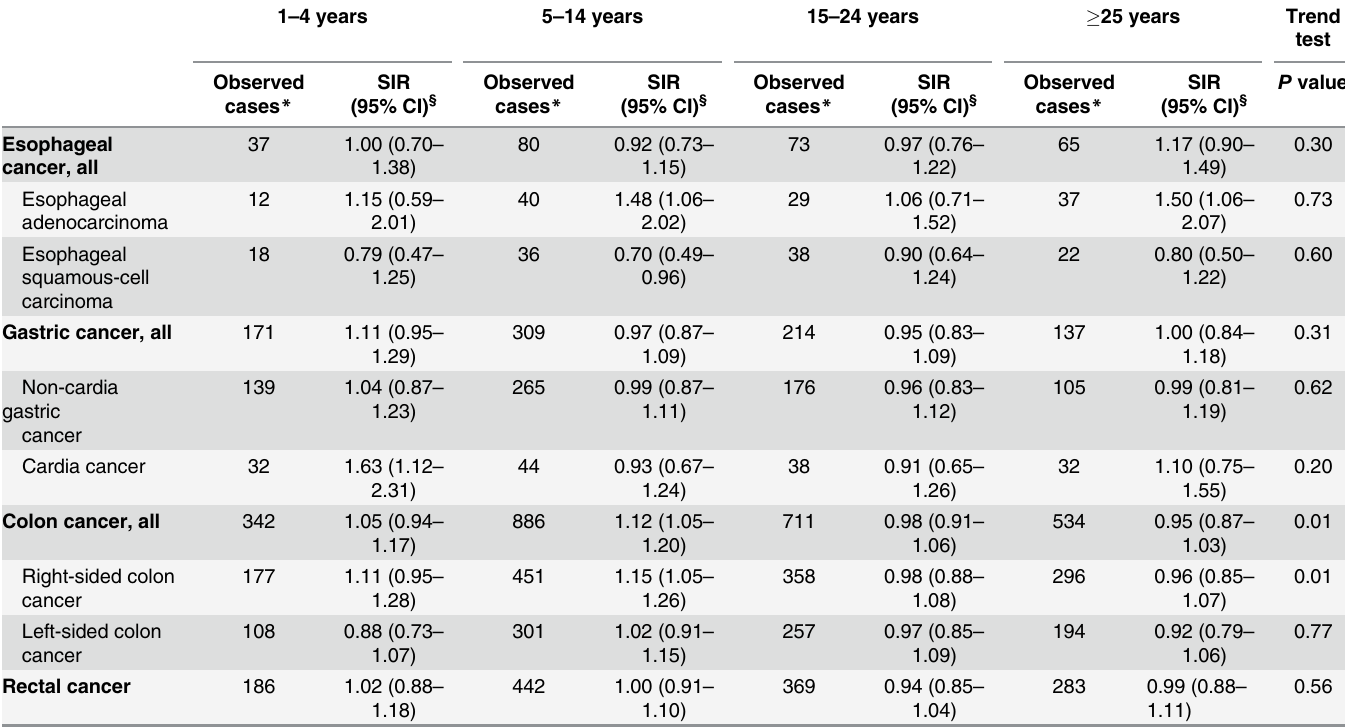
Table 3. Standardized incidence ratios (SIRs) and 95% confidence intervals (CIs) for gastrointestinal cancers in appendectomy patients, stratified by duration of